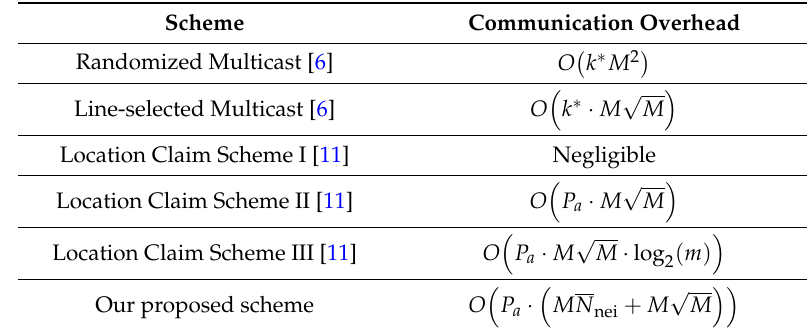
Table 2. Communication overhead comparison.